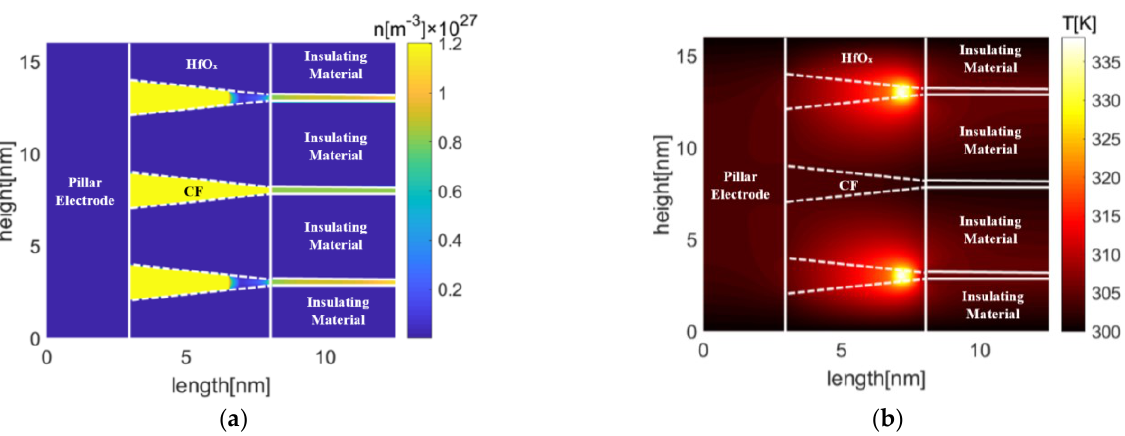
Figure 7. Distributions of ( a ) oxygen vacancy density and ( b ) temperature in GE-RRAM, where both the top and bottom cells are active, and captured at 0.2 s.